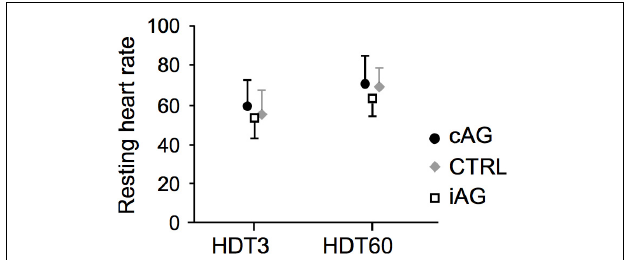
FIGURE 4 | Resting heart rate at the beginning (HDT3) and the end (HDT60) of the bed rest phase (cAG is represented by filled circles, CTRL by gray diamonds and iAG by open squares). There was a similar increase in resting heart rate for all three groups (no time ∗ group interaction effect, p = 0.39; significant main effect of time, p < 0.001).